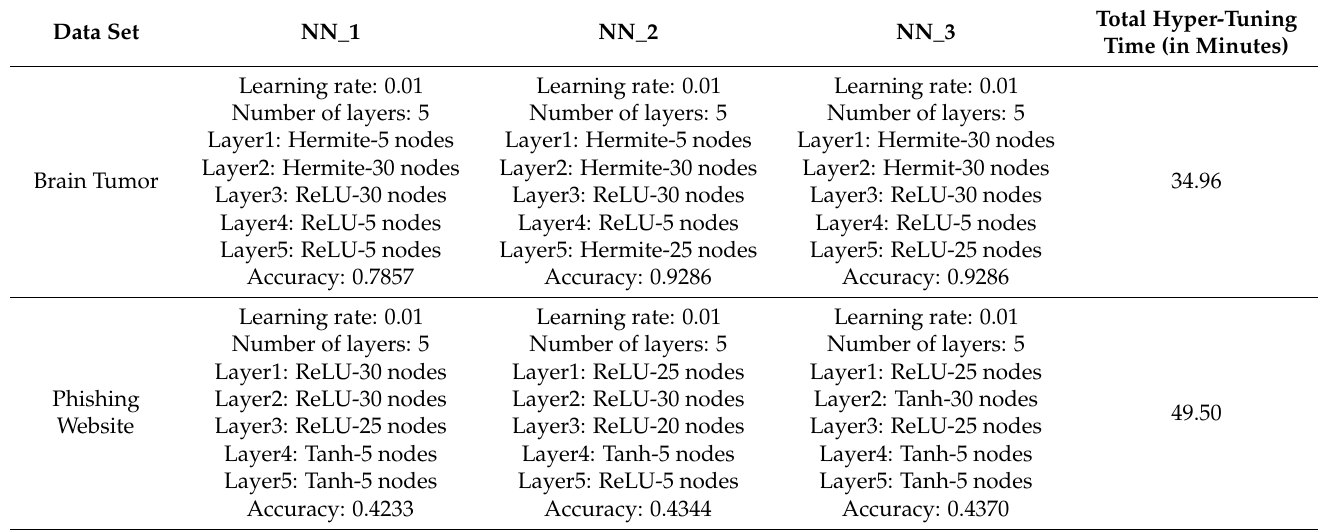
Table 7. (First Experiment) Optimal hyperparameter values, classification (i.e., validation) accuracy evaluated on the testing data, and the total time needed to perform the hyperparameter optimization (i.e., total hyper-tuning time) obtained by the three best neural networks: NN_1, NN_2, and NN_3 (Data sets: brain tumor and phishing